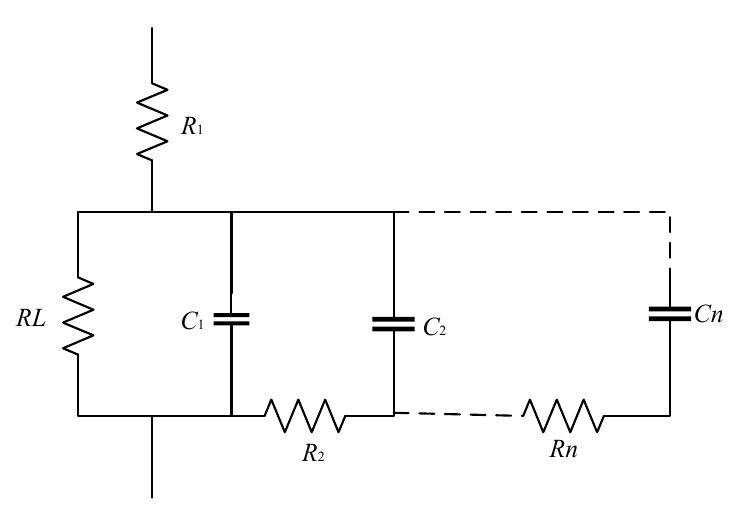
Figure 9. Ladder circuit model of a DLC.